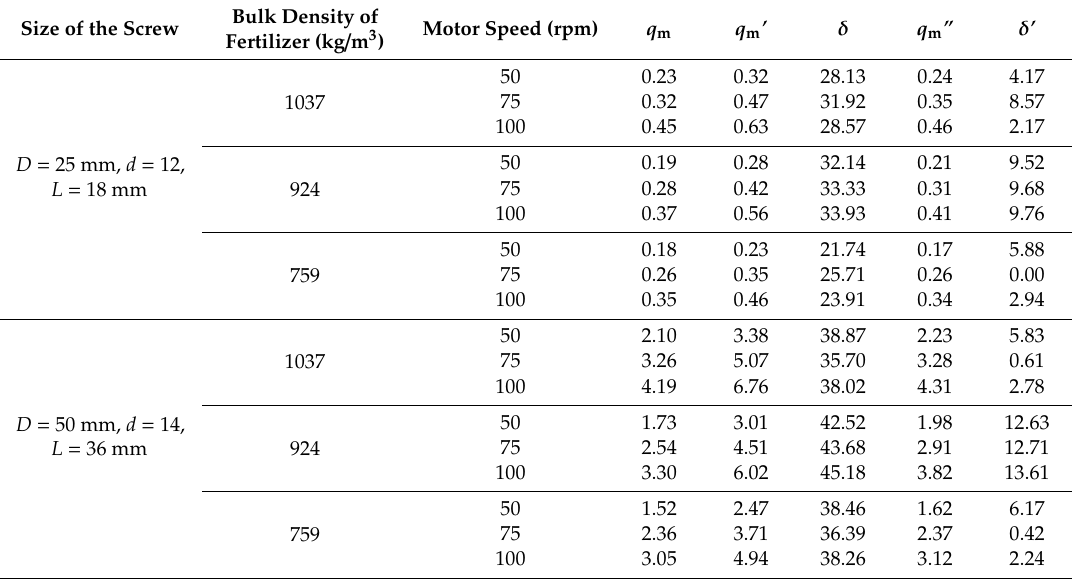
Table 1. Flowrate of the fertilizer-feeding component of the designed device under di ff erent parameters. Bulk Density of Motor Speed (rpm) q m q m ’ δ q m ” δ ’ Size of the Screw Fertilizer (kg / m 3 )